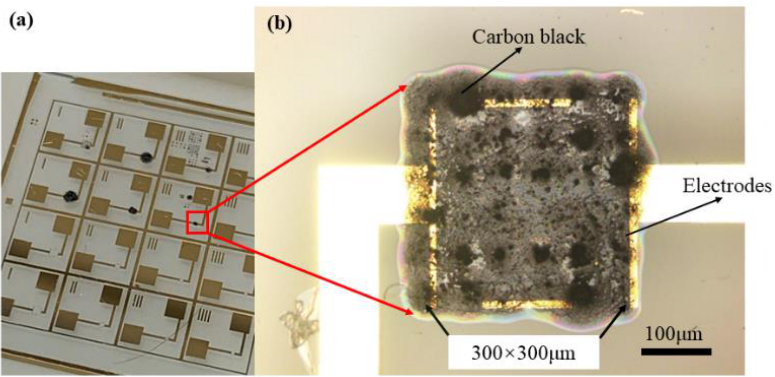
Figure 5. ( a ) Optical image of fabricated CB/PVA film sensor. ( b ) Micrograph of image of CB/PVA film.